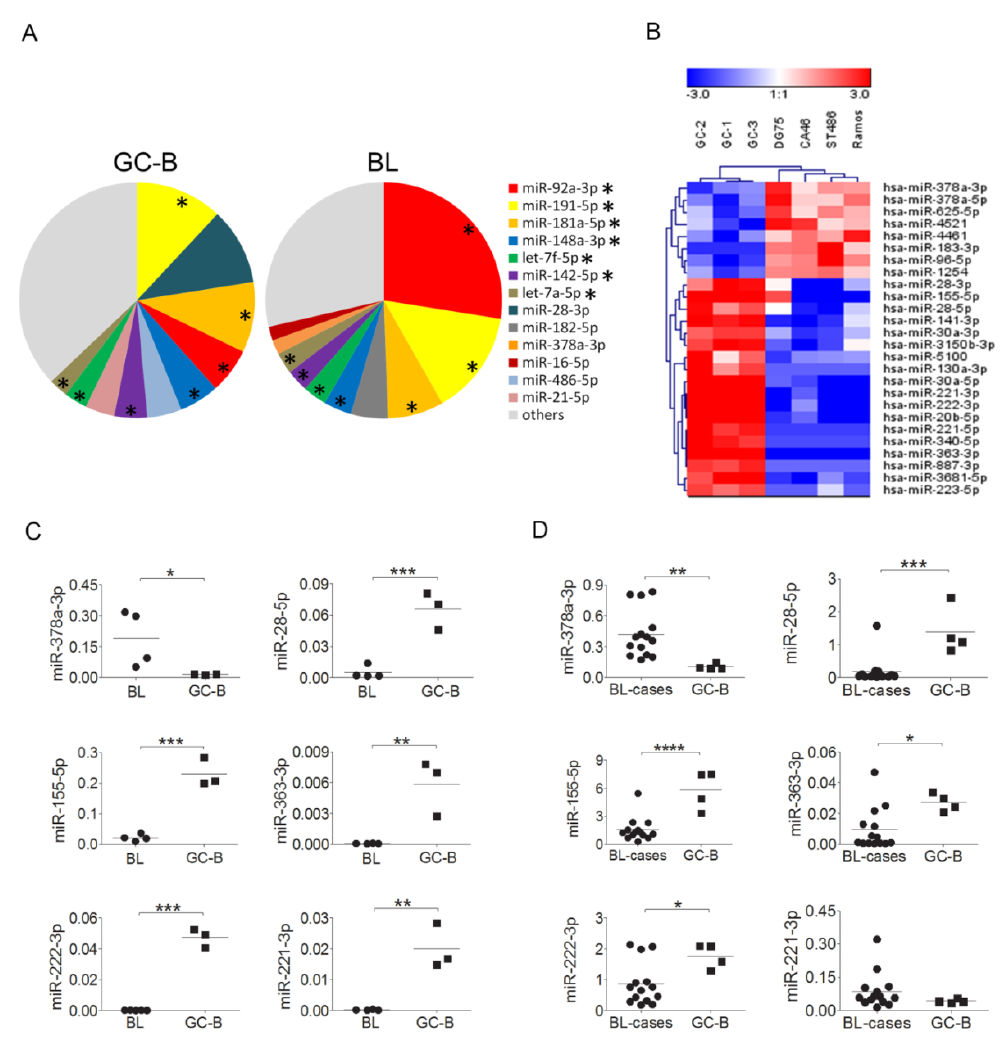
Figure 1. Deregulated expression patterns of microRNAs (miRNAs) in Burkitt lymphoma (BL) compared to germinal center B (GC-B) cells. ( A ) Overview of the top 10 most abundantly expressed miRNAs in Burkitt lymphoma (BL) and normal germinal center B (GC-B) cells as determined by small RNA-sequencing. Asterisks indicate miRNAs present in the top 10 of both BL and GC-B cells. ( B ) Heatmap of miRNAs significantly differentially expressed between BL and GC-B cells. ( C ) qRT-PCR validation results for six of the eight tested miRNAs with significantly differential expression between BL cell lines and GC-B cells. MiRNA expression levels were normalized to Small Nucleolar RNA C/D Box 44 (SNORD44). ( D ) The differential expression pattern was confirmed for five of the six tested miRNAs when BL tissues and GC-B cells were compared. MiRNA expression levels were normalized to Small Nucleolar RNA C/D Box 49 (SNORD49). Significant differences were calculated using an unpaired t -test. * p < 0.05, ** p < 0.01, *** p < 0.001, and **** p < 0.0001